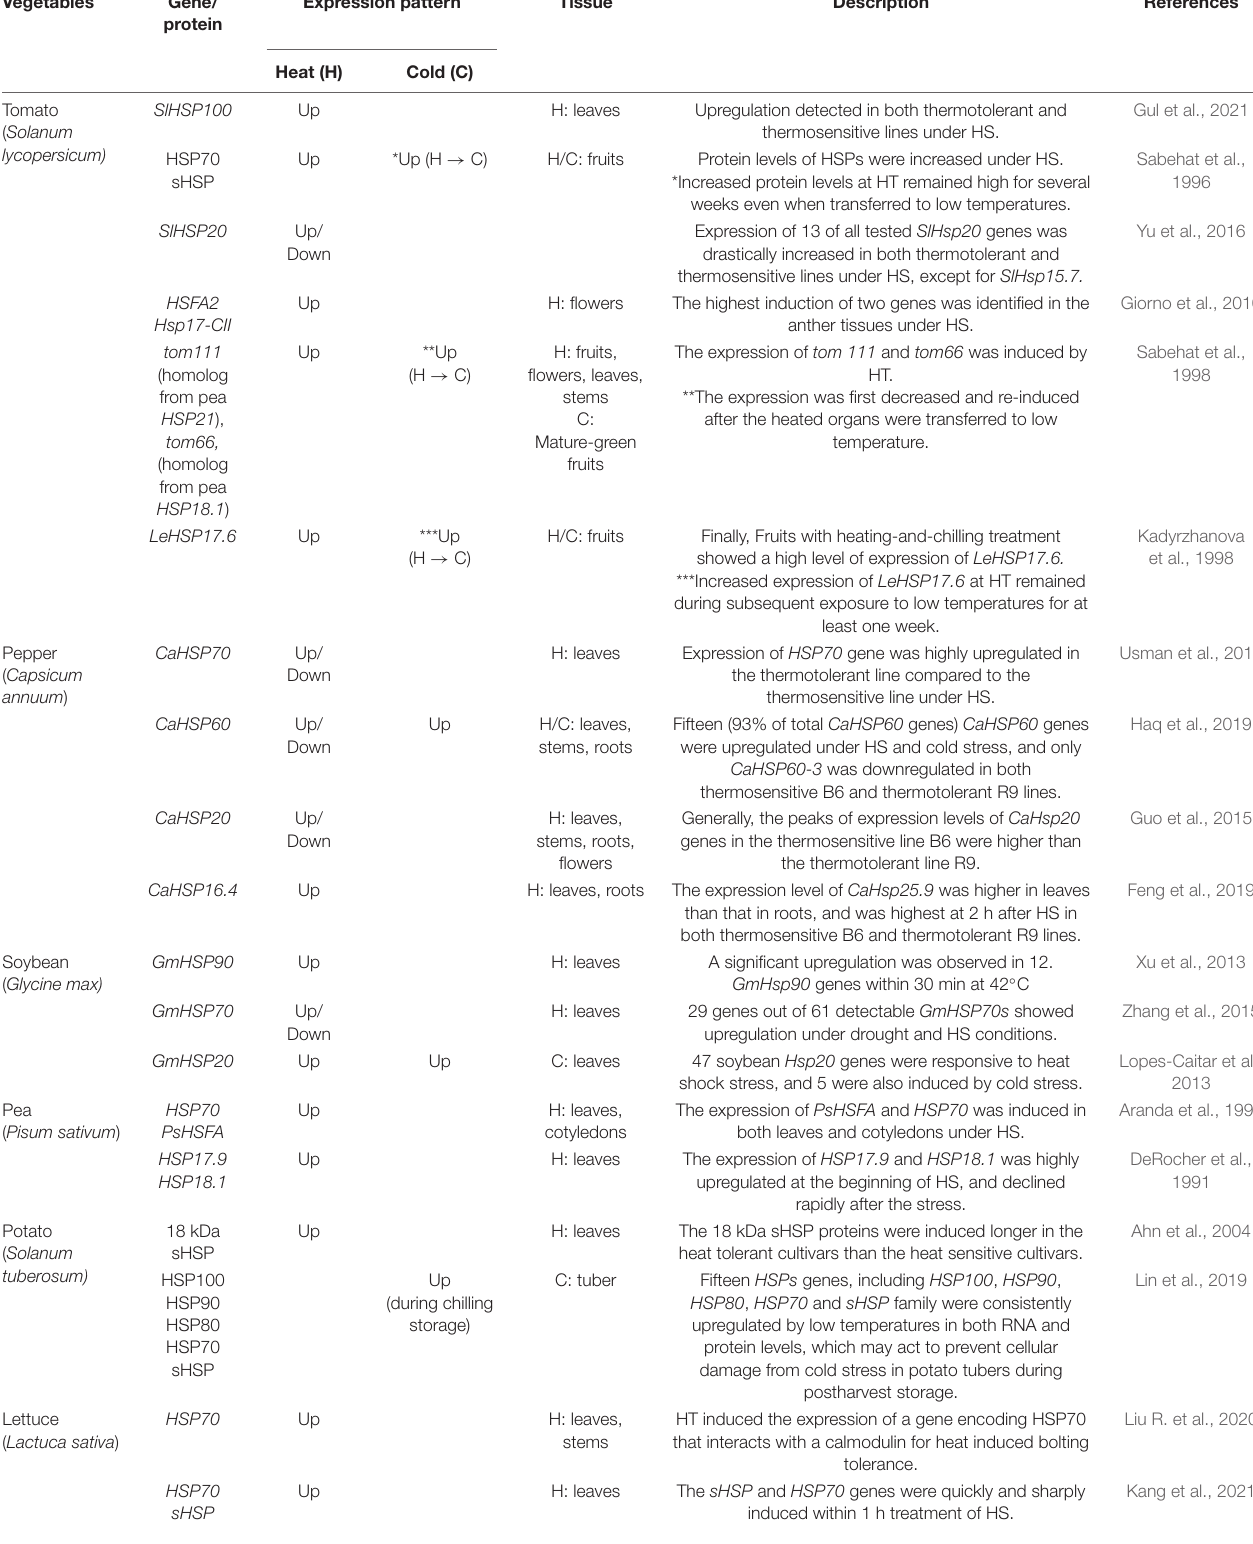
TABLE 2 | Gene expression pattern response to heat or cold stress in vegetables. Vegetables Gene/